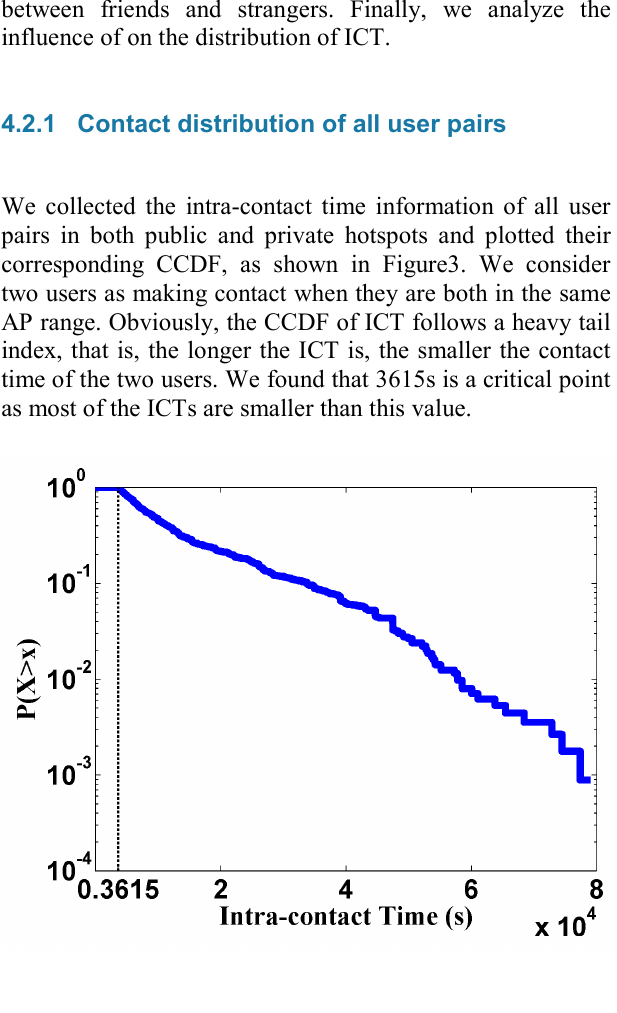
Figure 3. Intra-contact time CCDF for all